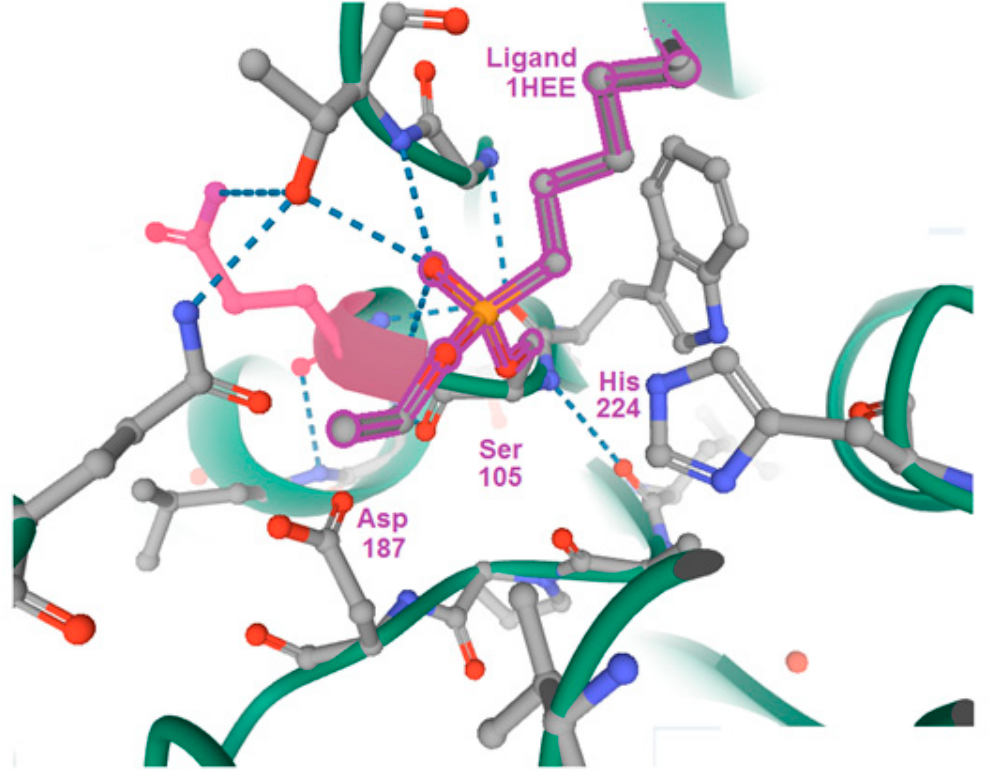
Figure 2. Nonspecifically bound ligand 1HEE, present in the active site of CAL-B in PDB structure 1LBS [29]. The Figure was created using RCSB PDB Jmol software [36,37].